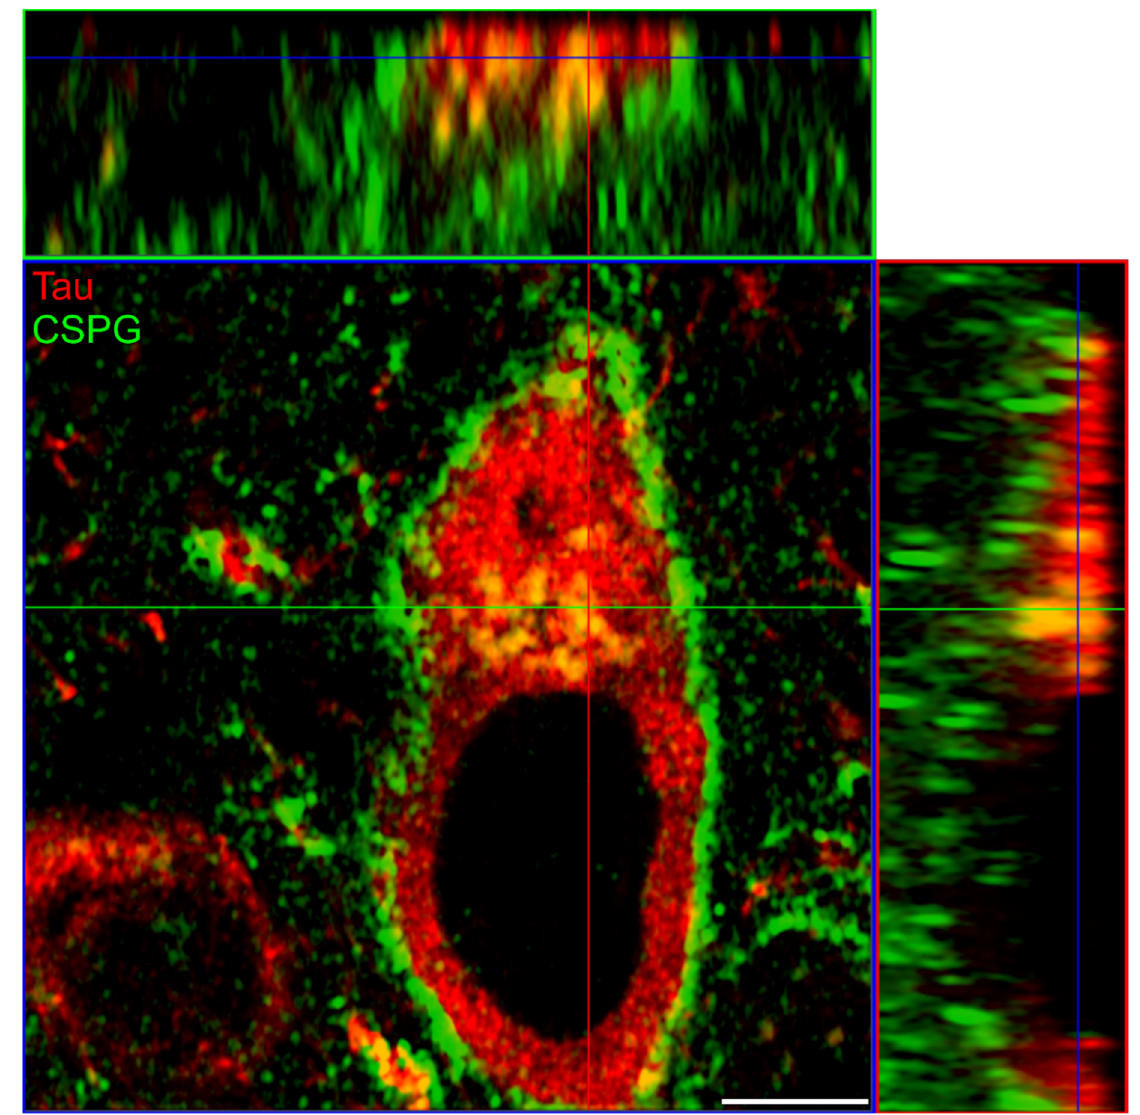
Figure 6. Location of tau protein and major PN components in the brainstem of TauP301L HET - acan WT mice. Representative immunofluorescent image of human P301L tau visualized with anti-human total tau antibody (red, clone 7E5 (Roboscreen)) and PN-associated CSPGs using anti-brevican antibody (BCAN, green, clone 2 (BD Biosciences)). Orthogonal view of the high magnification confocal image revealed an intracellular colocalization of human P301L mutated tau (red) and the CSPG brevican in brainstem neurons. Scale bar in 5 µ